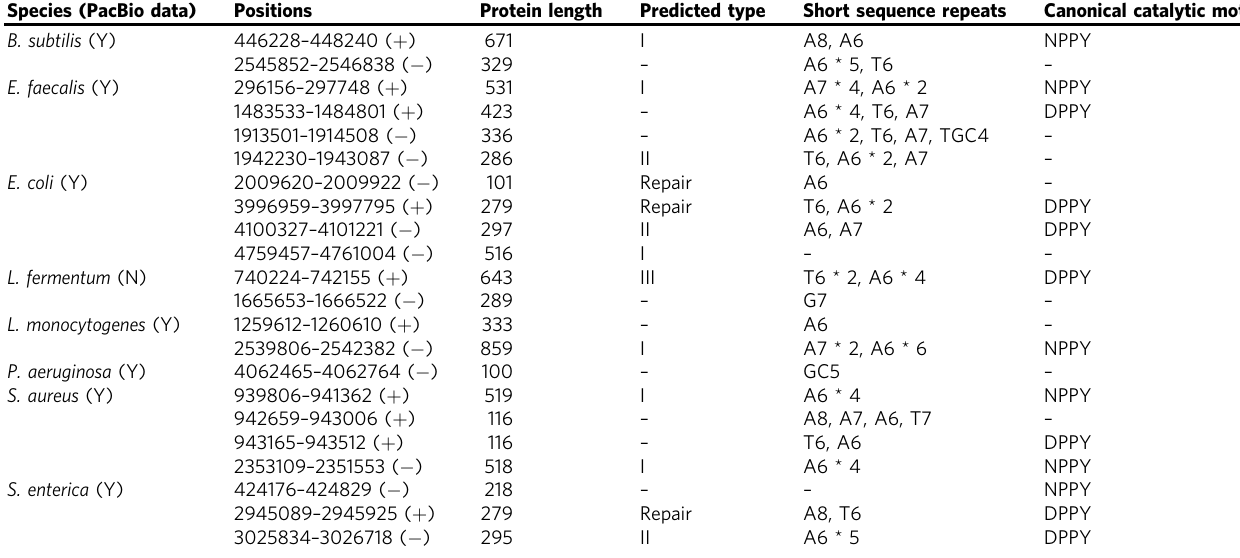
Table 1 Predicted DNA methyltransferase genes and their features in reference community bacteria Species (PacBio